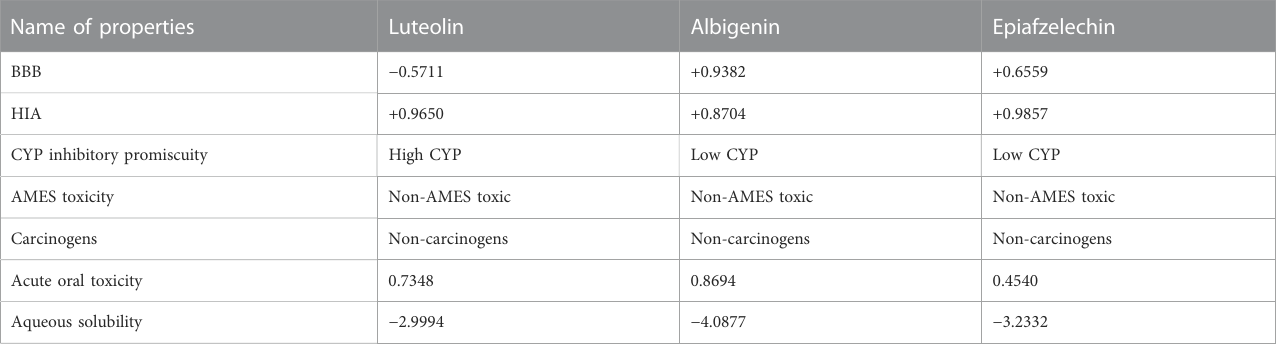
TABLE 3 ADMET pro fi le analyses of phytocompounds.